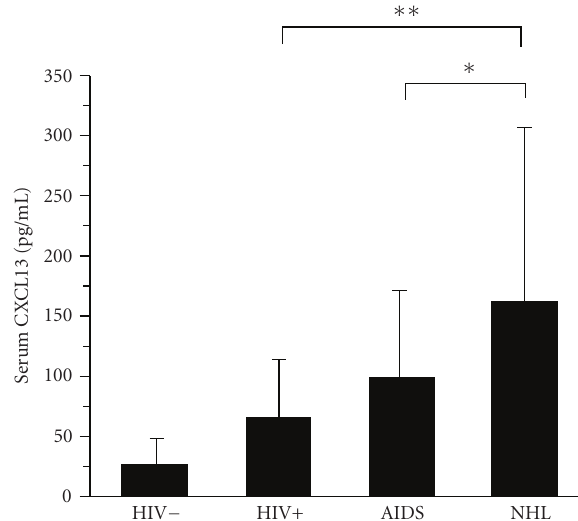
Figure 1: Serum CXCL13 levels are elevated prior to development of AIDS-NHL. Serum from each person in the AIDS-NHL group ( n = 46) was obtained for one time point in the 2.5 years prior to the development of lymphoma; subjects in the AIDS control group ( n = 41) had AIDS, but no malignancy. Subjects in the HIV(+) group ( n = 43) were HIV-seropositive, non-AIDS, and had CD4 T cell numbers > 500cells/mm 3 . Serum CXCL13 levels were determined by ELISA. Subjects in the HIV( − ) group ( n = 40) were HIV-seronegative. Analysis was performed on the logarithmic scale, but we report means and standard deviations for CXCL13 on the original scale using the delta method, as previously reported [25]. Bars represent mean values; error bars represent standard deviations, ( ∗ P < .05, and ∗∗ P < .001). Although not indicated in the figure, all other comparisons (HIV+ versus HIV − , AIDS versus HIV+, HIV − versus AIDS, and AIDS-NHL versus HIV − ) were also significant, P < .